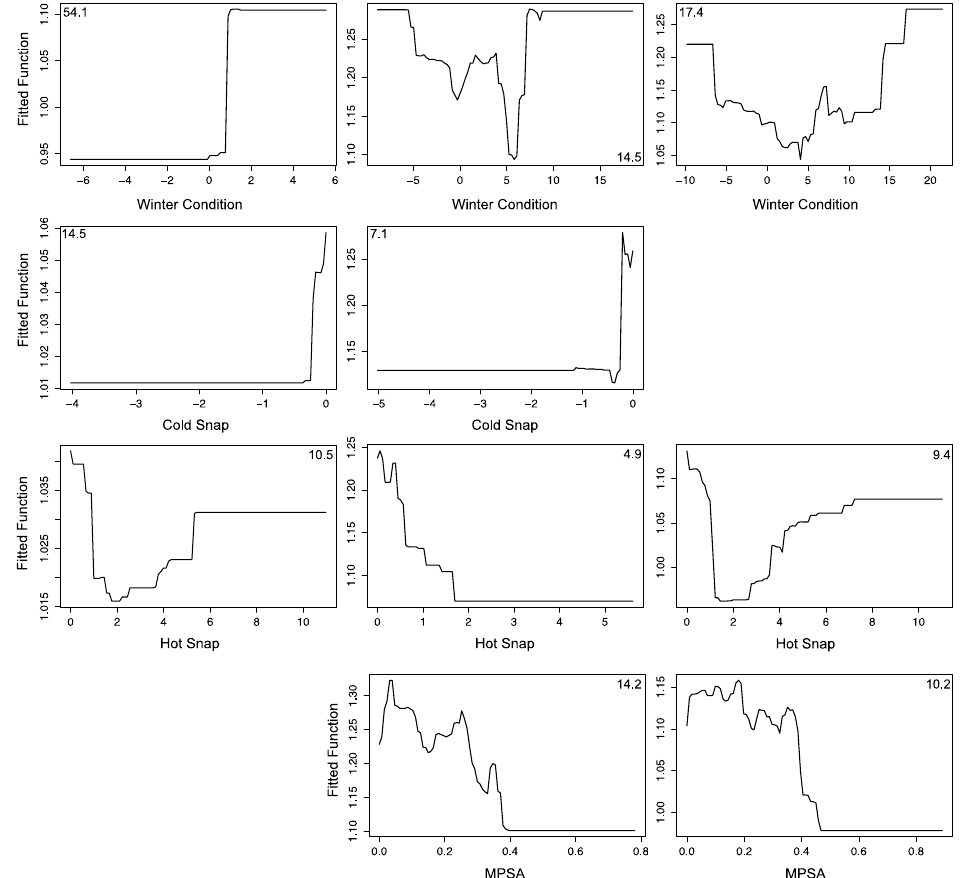
Figure 3. Partial dependence plots relating coral disease prevalence to demographic and thermal predictor variables for prevalence-if-present models. Plots show the probability of disease prevalence across a range of values for the predictor variable, while accounting for the average effects of all other variables in the model. Models were developed with a randomly chosen 75% of the dataset and were tested using the 25% withheld. Relative influence of each predictor variable is shown as a percentage in a corner of each graph. We did not incorporate non-informative predictors, which were determined using the R function gmb.simplify , and therefore we do not show partial dependence plots for those variables (blank spaces). Host density is specified by genus ( i.e. , Montipora or Porites density). MPSA is Mean Positive Summer Anomaly.